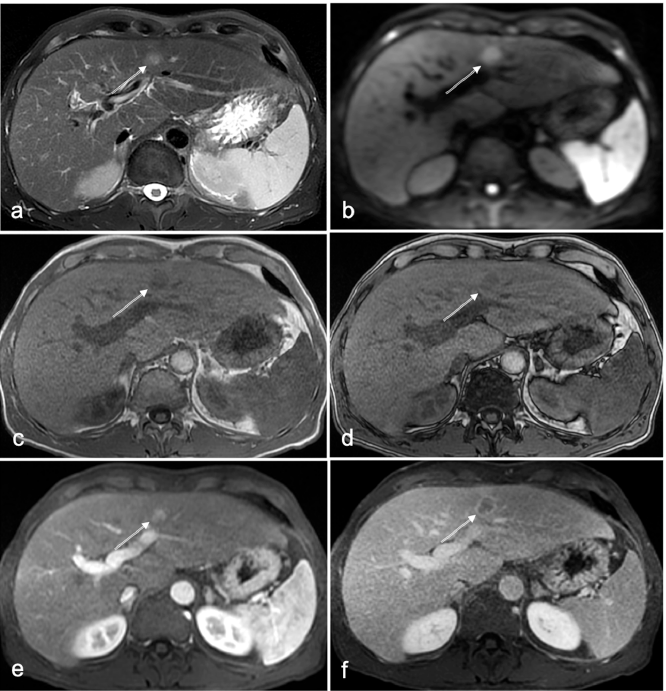
Figure 1. ROC curve for the three readers. Area under the curve (AUC): reader I 0.94 (95% CI 0.90–0.99), reader II 0.88 (95% CI